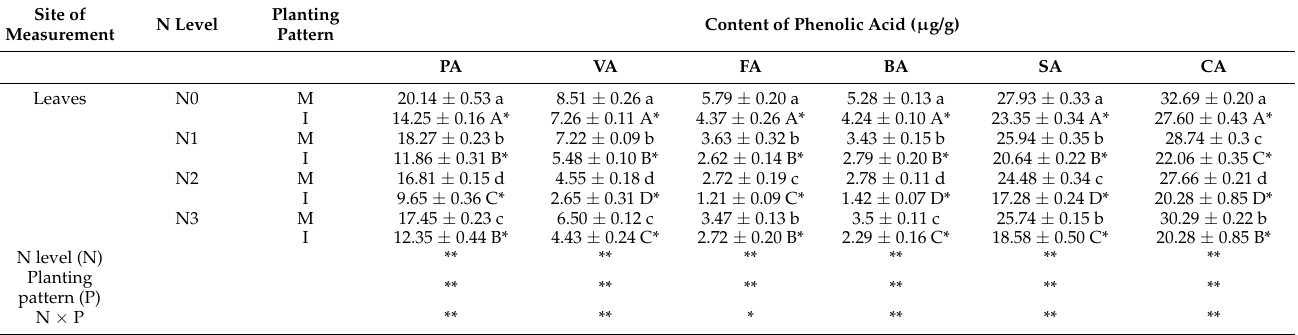
Table 4. Effects of nitrogen application and intercropping on phenolic acid content in faba bean leaves.